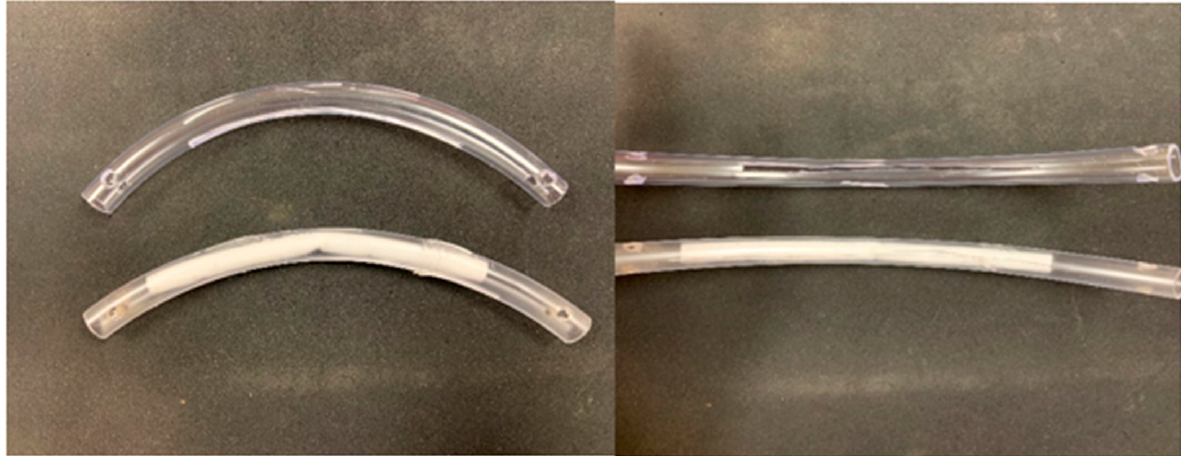
Figure 1. The Modified Bit Developed at Fieldstone Farm (side and front views).